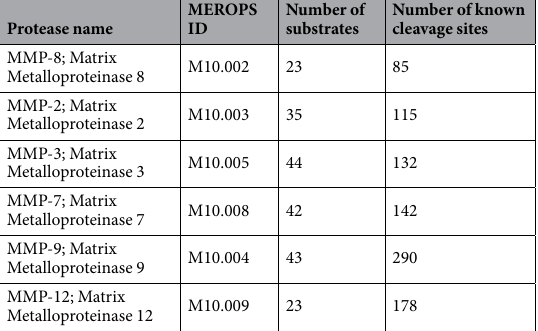
Table 3. Statistical summary of MMP-specific substrate datasets used in this